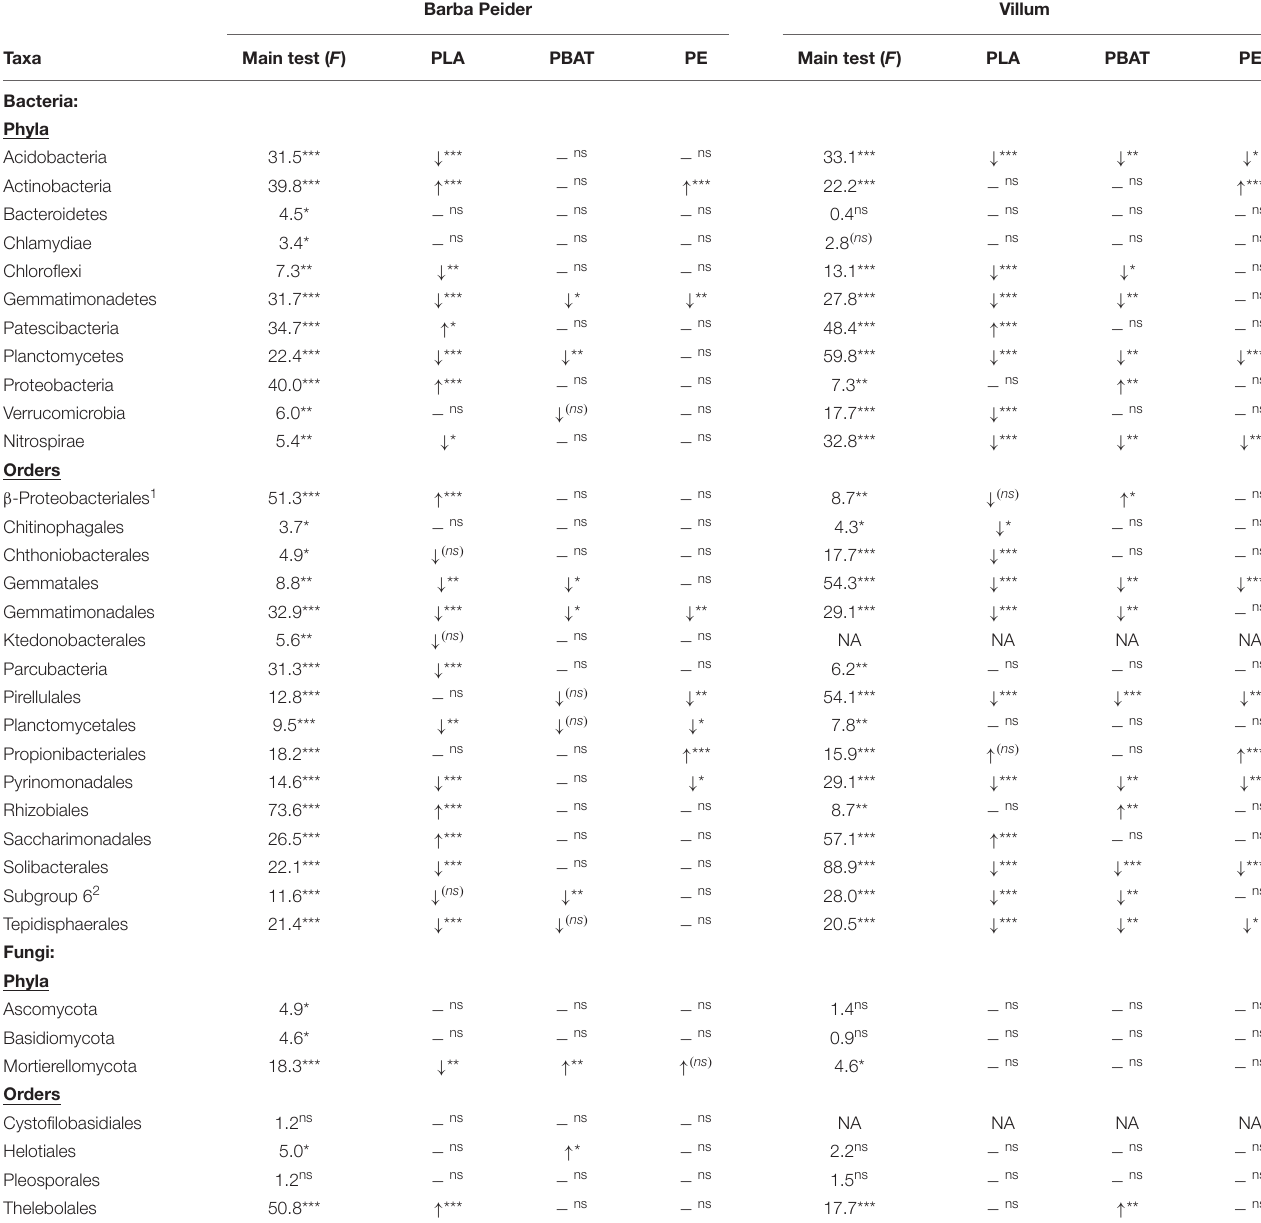
TABLE 5 | Changes in the relative abundance of prokaryotic and fungal phyla and orders in the plastisphere. Barba